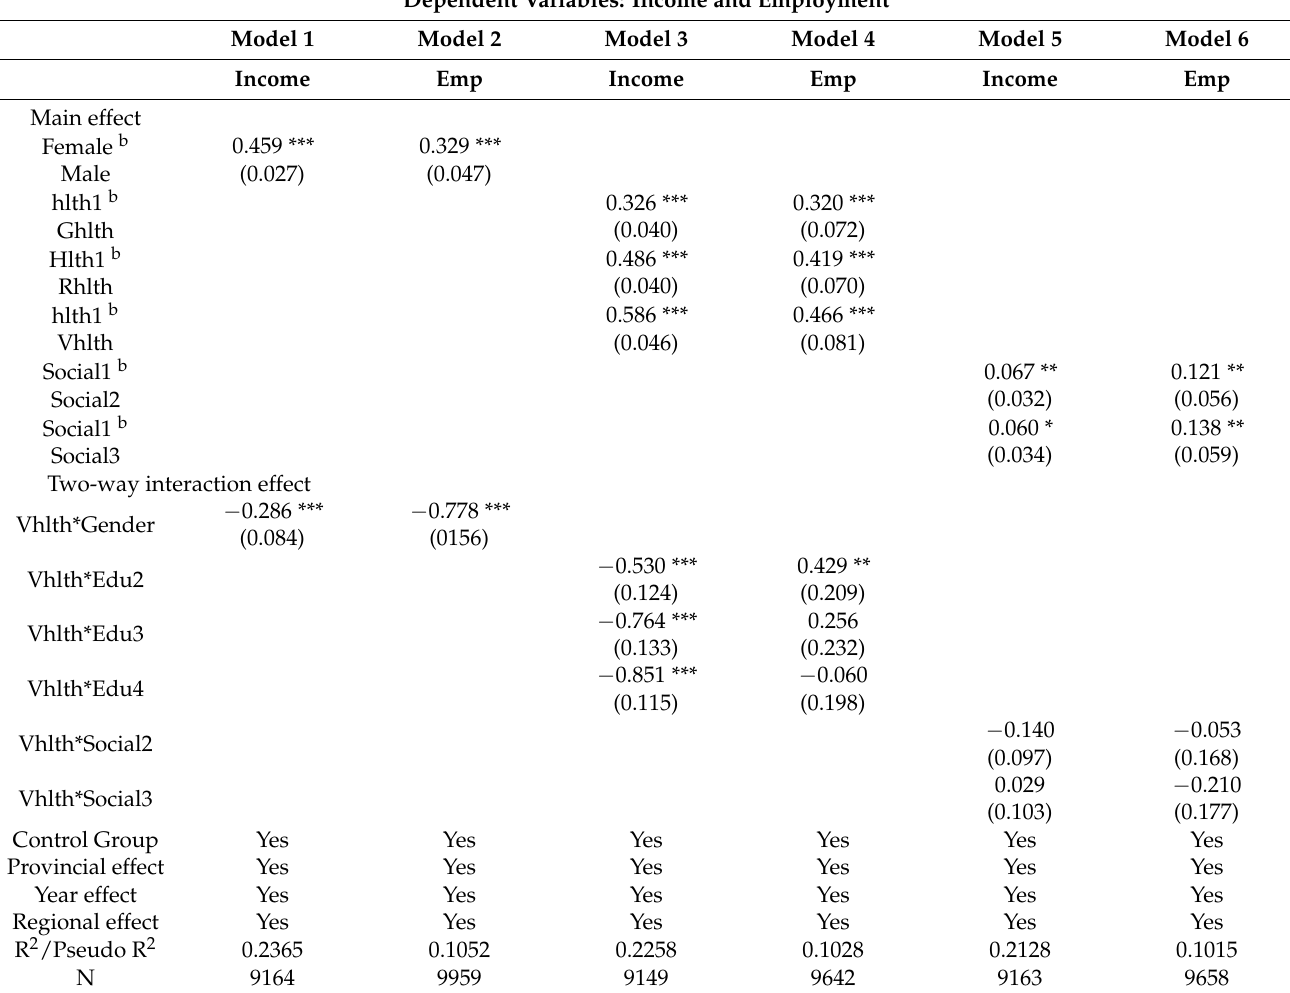
Table 8. Interaction effect of gender, education, social interaction, and health on an individual’s income and employment CGSS 2013 and